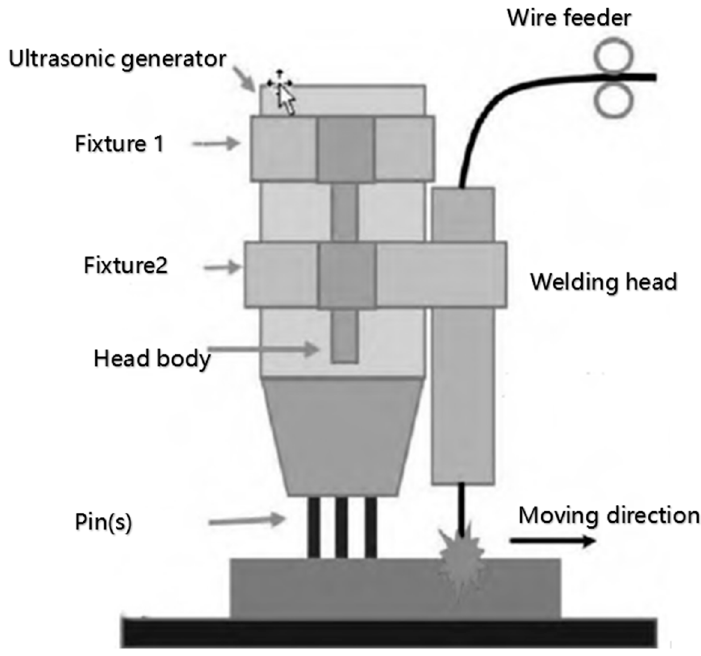
Figure 5. Schematic diagram of joint equipment.